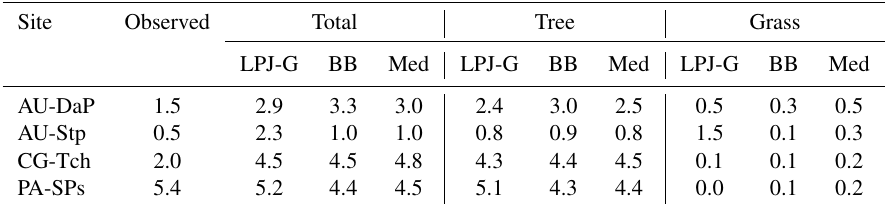
Table 11. Observed and simulated LAI at the four C 4 grassland sites when all natural PFTs are allowed to grow in the patch. The BB and Med values correspond to LSM simulations using the CLM-type water uptake response function. Site Observed Total Tree Grass LPJ-G BB Med LPJ-G BB LPJ-G